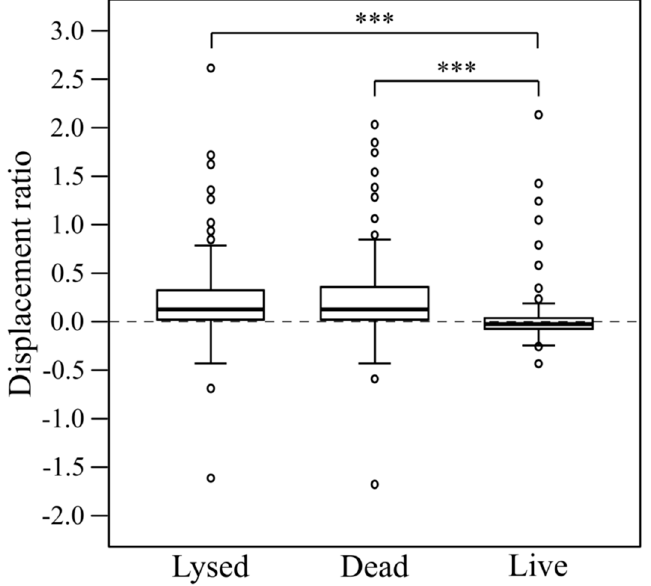
Figure 6. Comparison of myxobacterial displacement ratios obtained on lysed, dead and live prey cells. Asterisks (***) signify highly significant differences ( p < 0.001, n = 28).